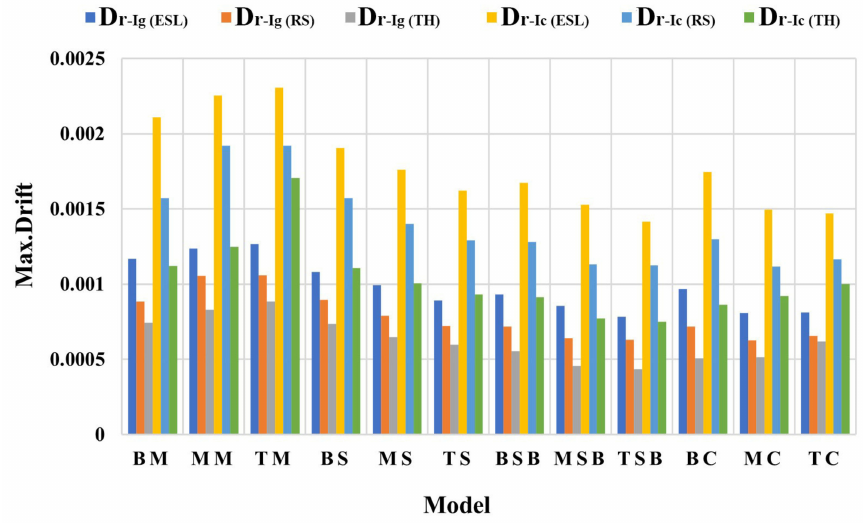
Figure 11. Maximum inter-story drift for different irregularity